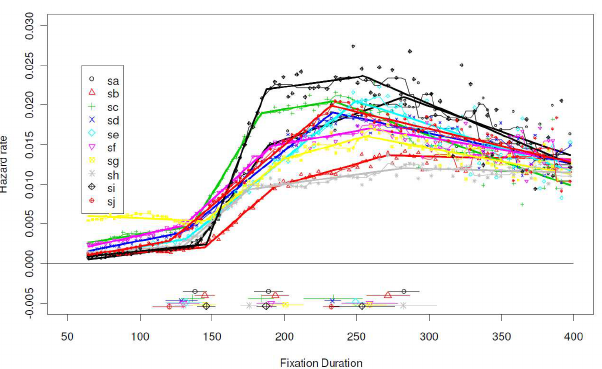
Figure 5. Individual Differences in Hazard Function: 10 Adult Readers from the Dundee